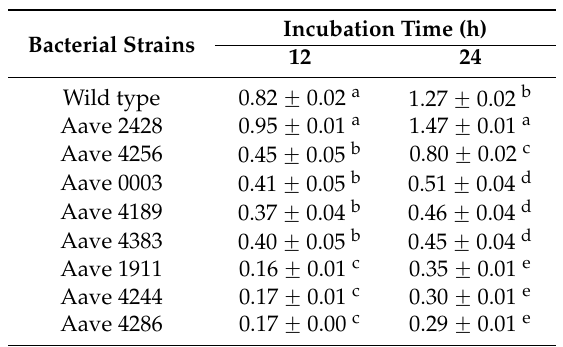
Table 3. Effect of incubation time on the growth of virulence-related mutants of biofilm-defective strain A1 in LB